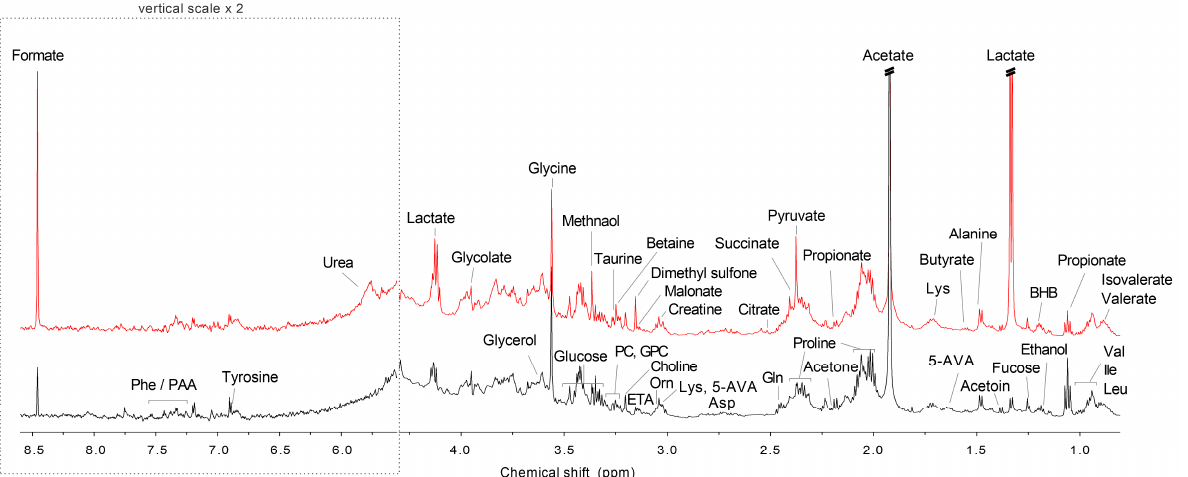
Figure 1. Representative 1 H NMR spectra of saliva samples from study participants with caries (Red color) and the healthy control (Black color). Abbreviations: 3-HIA: 3-Hydroxyisovalerate; 5-AVA: 5-